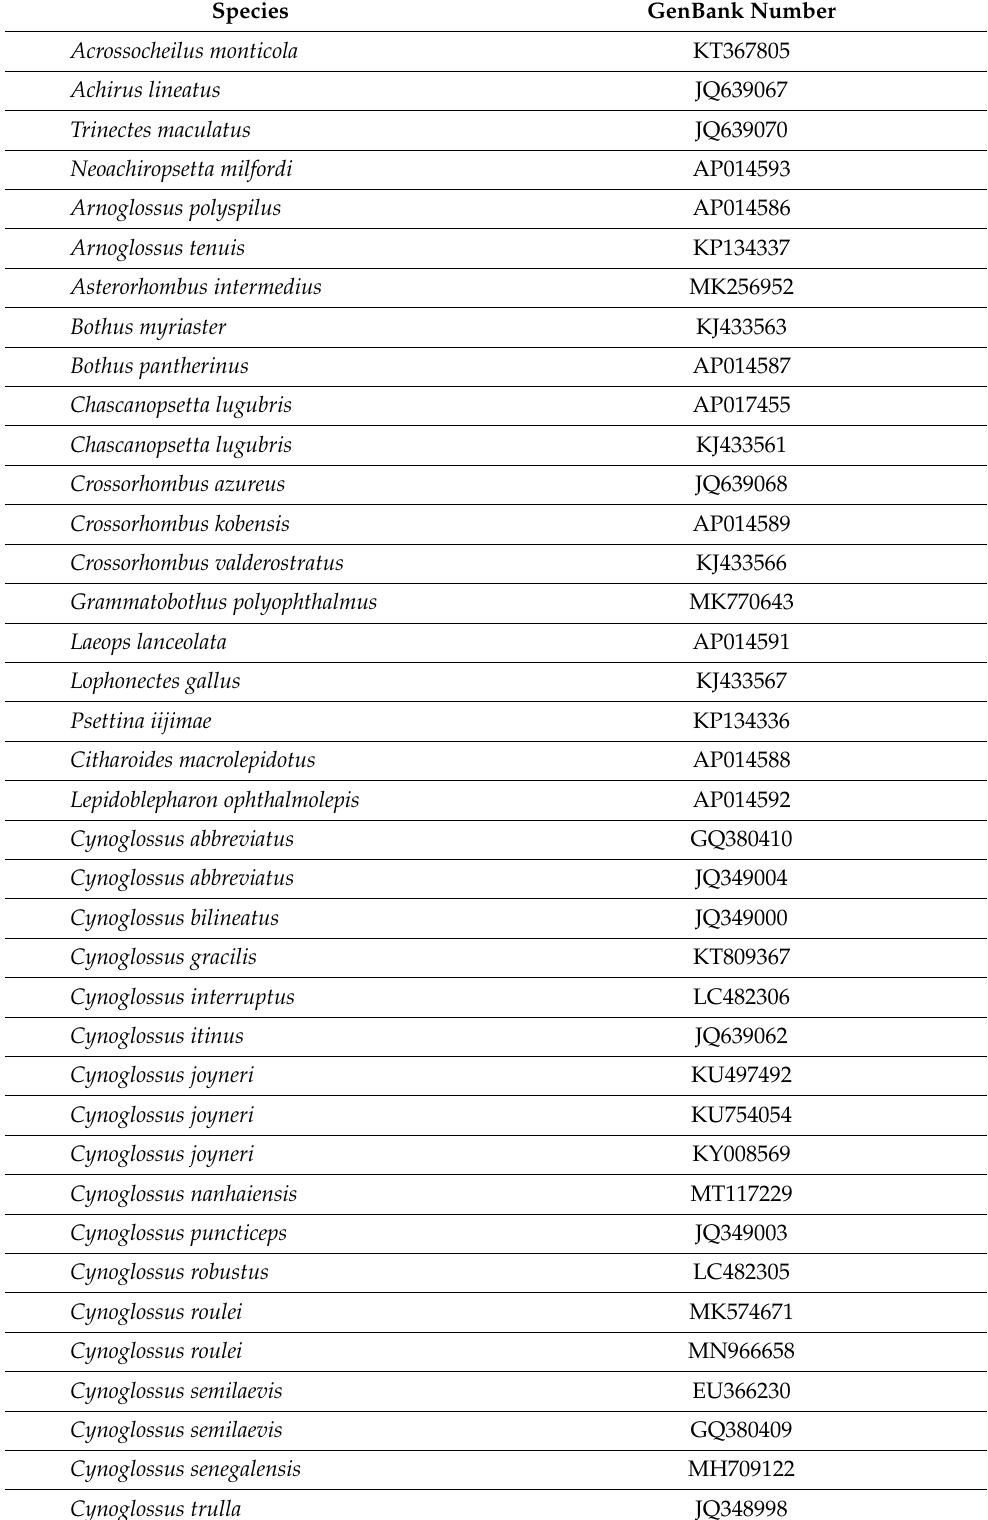
Table 1. Species list used in the study with the GenBank accession